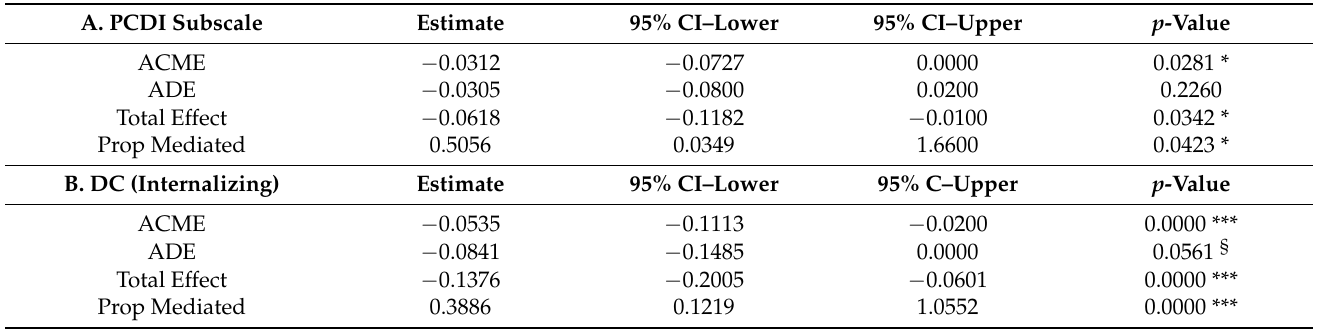
Table 3. PSI-4-SF questionnaire: by-hand moderation model and multiple mediation